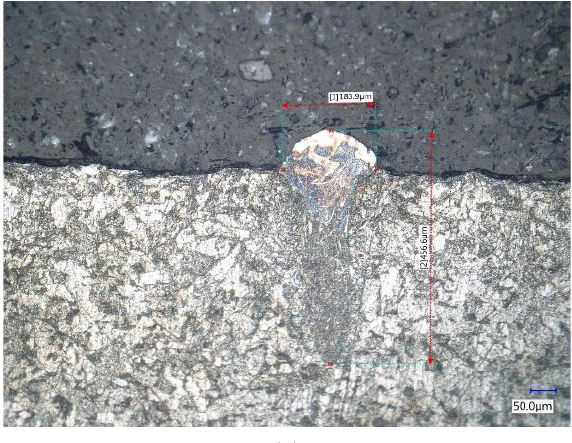
Table 9. Evaluation of selected welds based on metallographic analysis (red + grey — unsuitable, yellow — partially suitable, green — suitable).